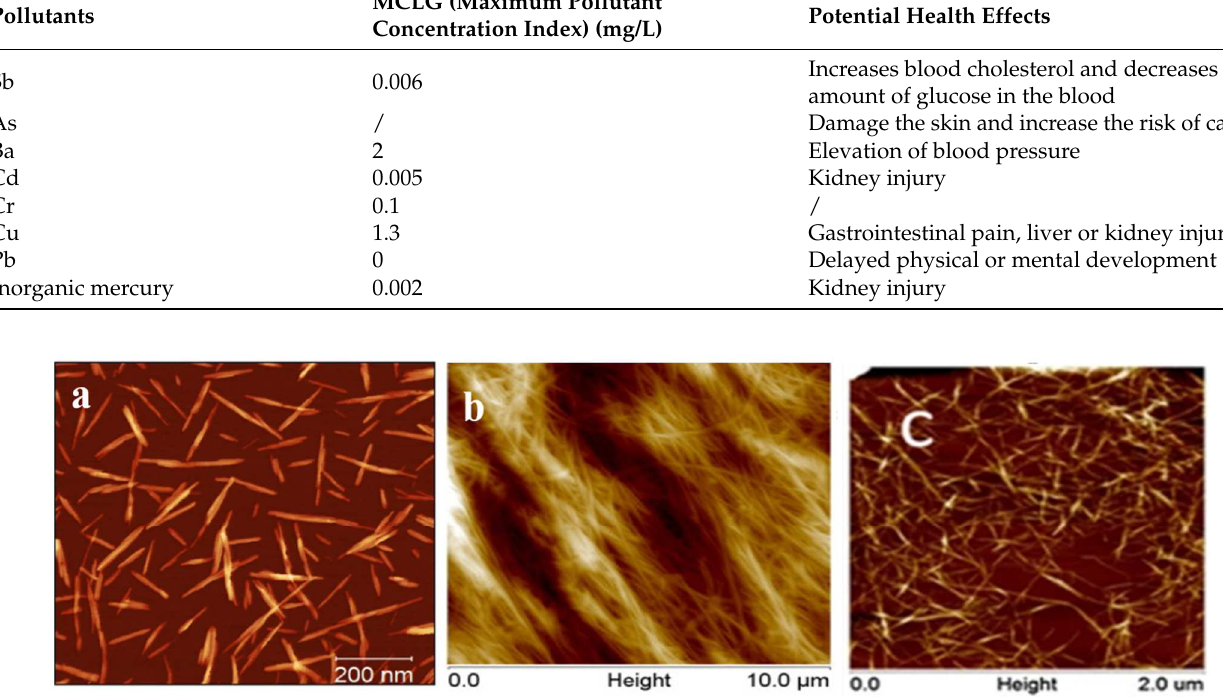
Figure 1. Atomic force microscope (AFM) images of ( a ) CNC, ( b ) BNC, and ( c ) CNF. Adapted